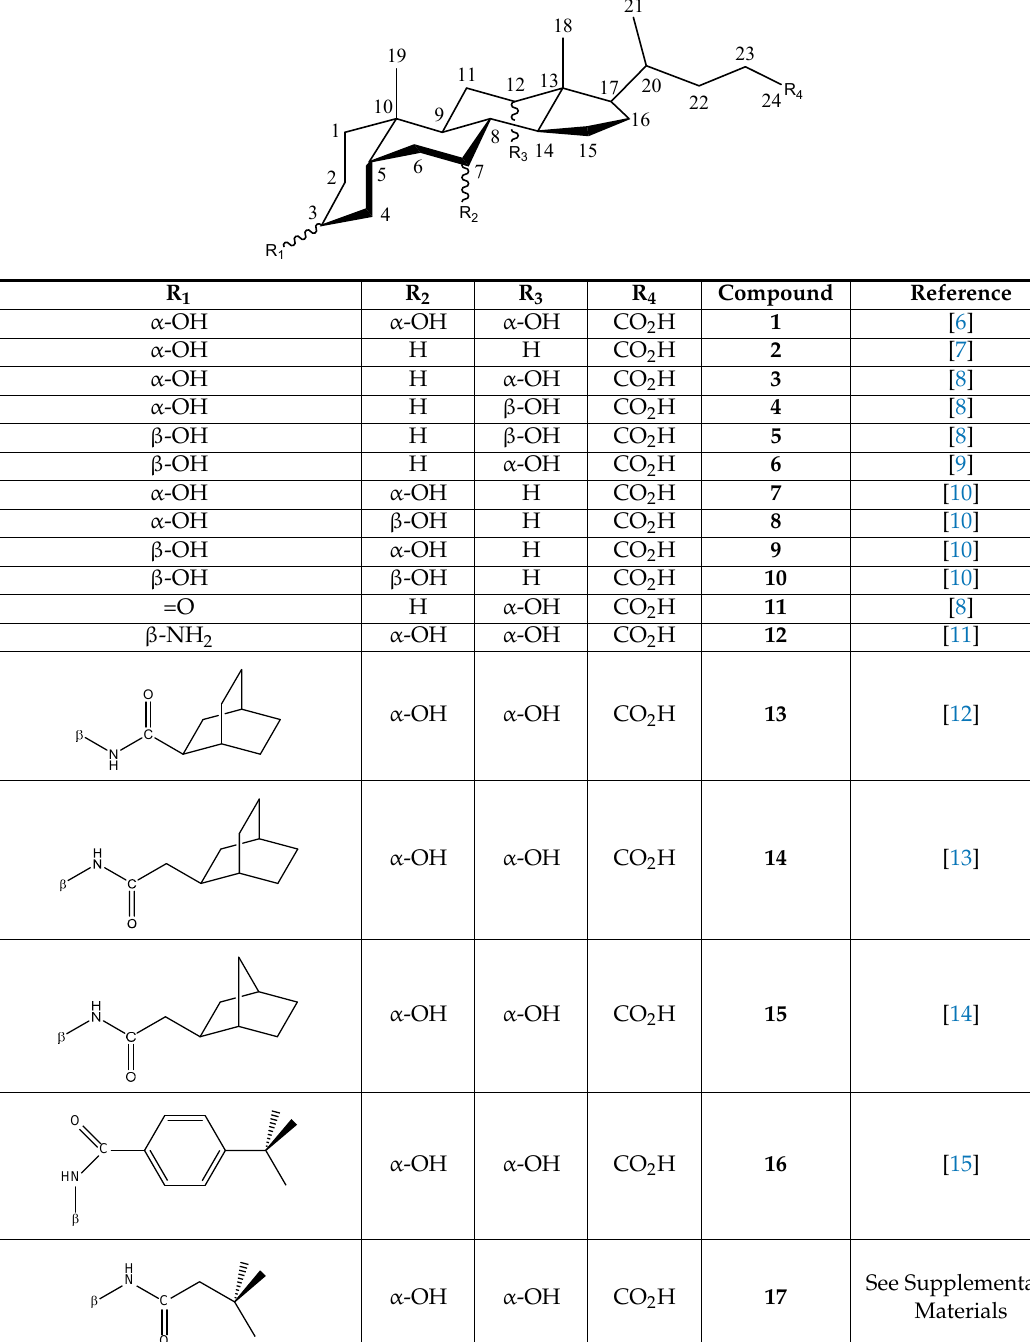
Table 1. Chemical structure and numbering of the bile acids (R 4 = CO 2 H), bile acid esters (R 4 = CO 2 CH 3 ), and 24-amino derivatives (R 4 = NH 2 ) reviewed in this paper.